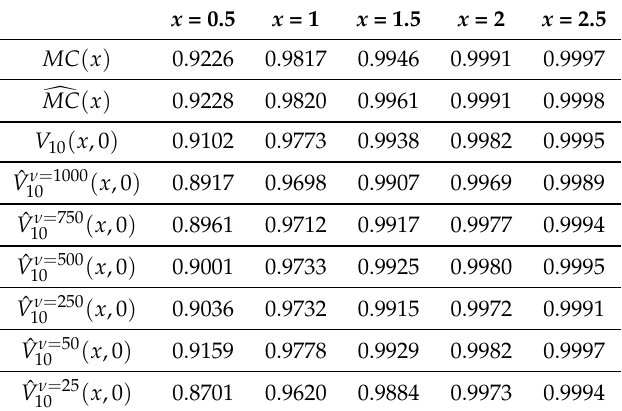
Table 2. Development of the solution with estimation due to variation of the sample size ν .